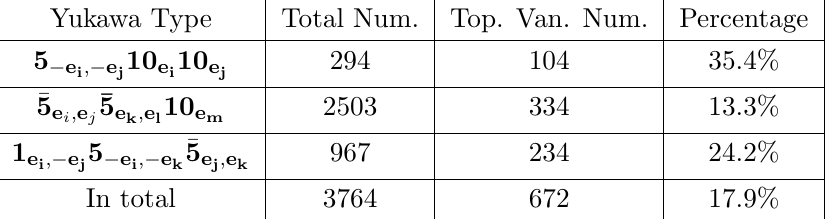
Table 6 . The total number of Yukawa couplings of each type in the Line Bundle Standard Model data set studied [19, 20, 105]. The column ‘Total Number’ details the number of each type of coupling which are consistent with gauge invariance. The column ‘Top. Van. Num.’ details the number of these couplings that are actually zero due to the vanishing theorem